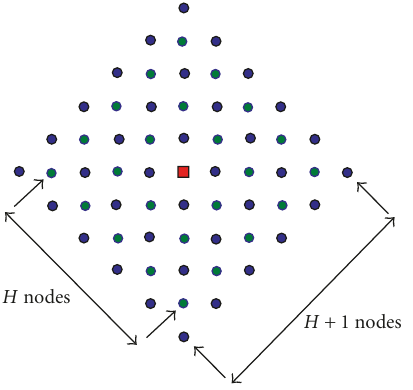
Figure 7: Total nodes within L 1 distance (cid:4) H is 2 (cid:4) H 2 + 2 (cid:4) H .